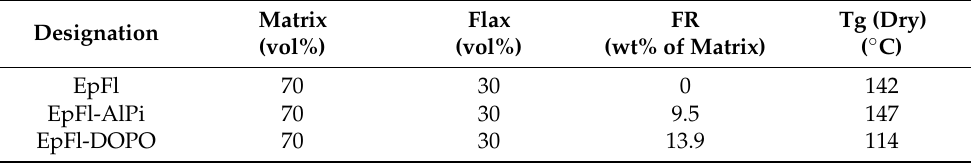
Table 1. Composition of the different biocomposites and their Tg before